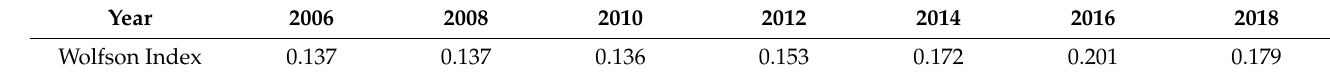
Table 7. Spatial polarization trend of EWP in China: based on the Wolfson index.